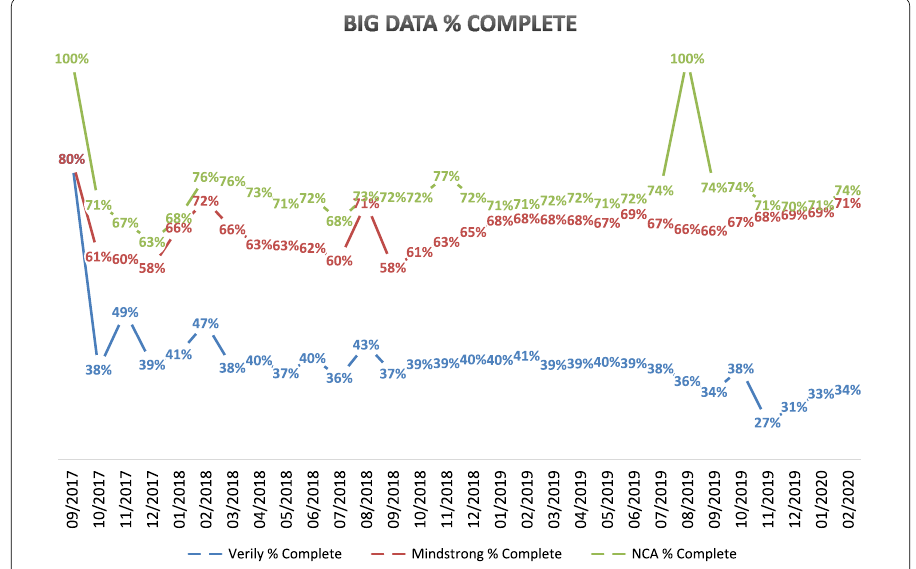
Figure 3 Compliance to wearable, flash surveys/digital phenotyping, and neurocognitive assessments. Interim compliance related to ecological/passive, digital phenotyping, and online neurocognitive assessments are